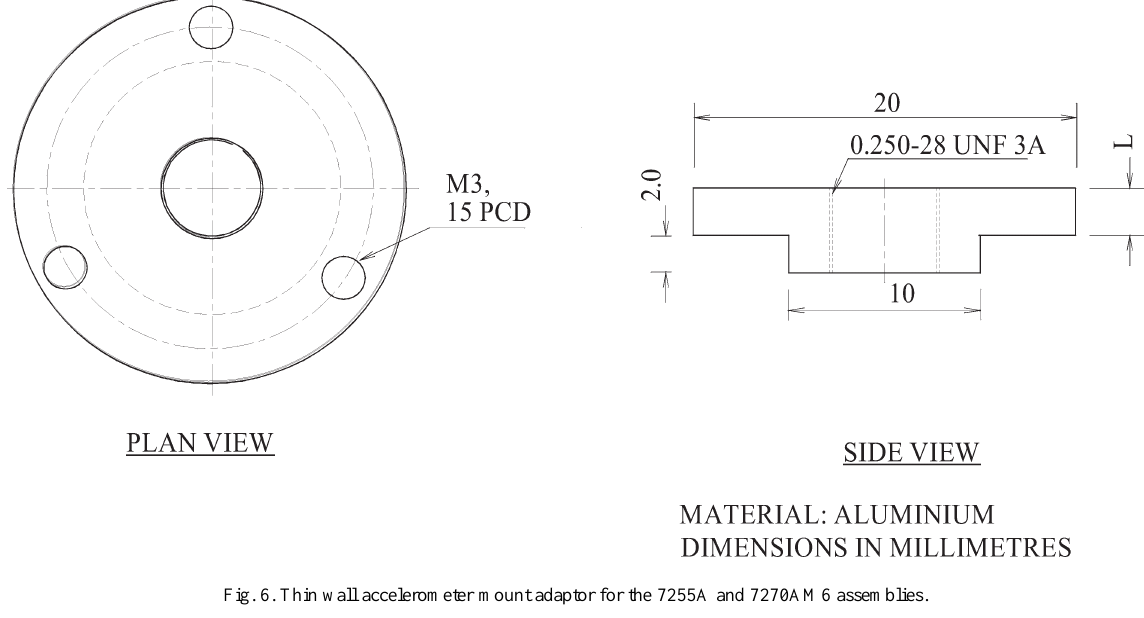
Fig. 6. Thin wall accelerometer mount adaptor for the 7255A and 7270AM6 assemblies.